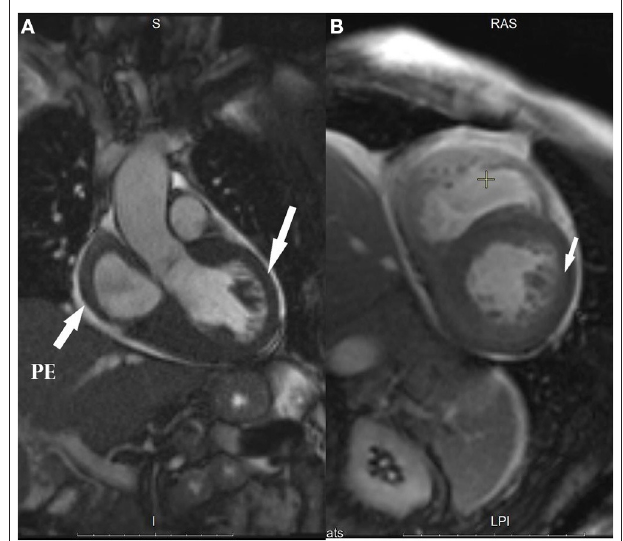
FIGURE 1 | Cardiac MRI images: (A) Left ventricle (LV) outflow tract (arrows show ventricular hypertrophy and pericardial effusion, PE); (B) Two-chamber views (arrow shows global subendocardial